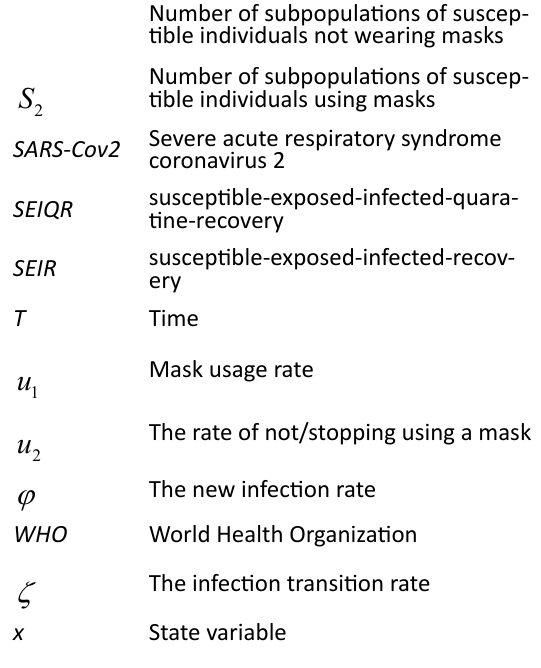
The rate of recovered individual back to susceptible not wearing masks The rate of recovered individual back to susceptible wearing masks The birth or death rate of individuals in the